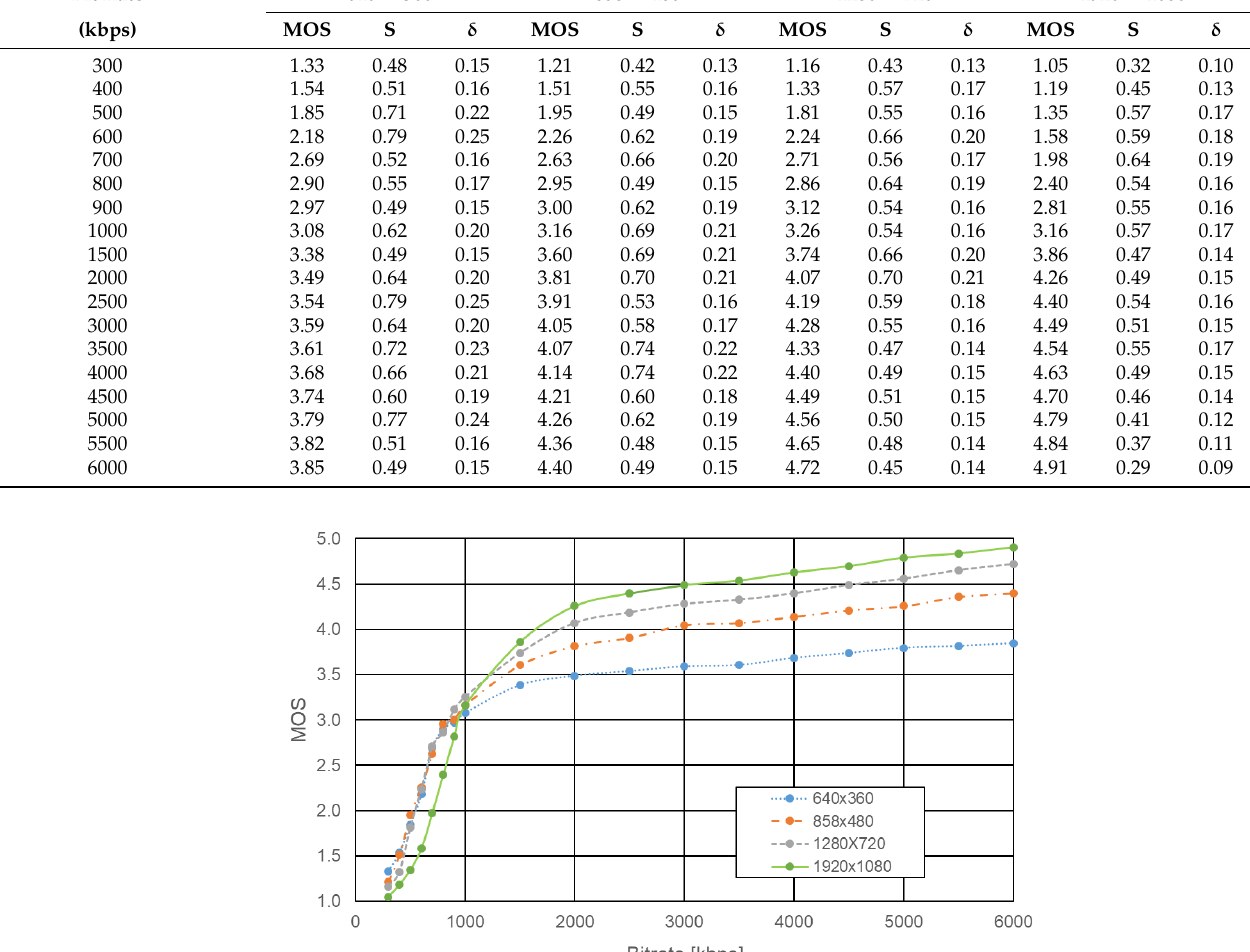
Figure 6. Results of the subjective quality assessment (MOS) for the H.264-encoded video as a function of bit rate for different spatial resolutions—measurements in the laboratory.